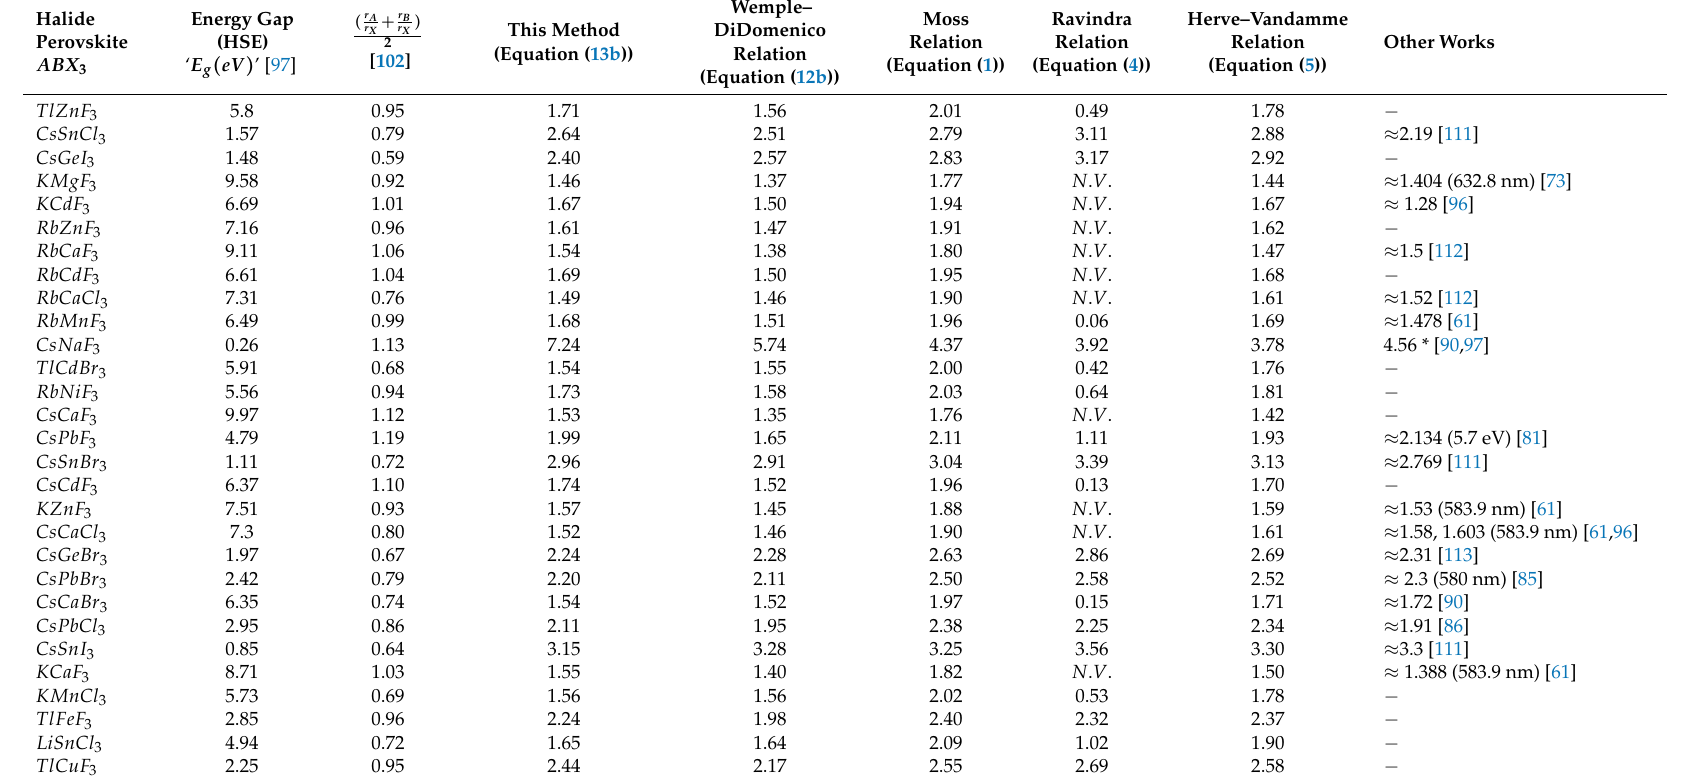
N . V . represents a negative value; * orthorhombic lattice, E g = 0.019